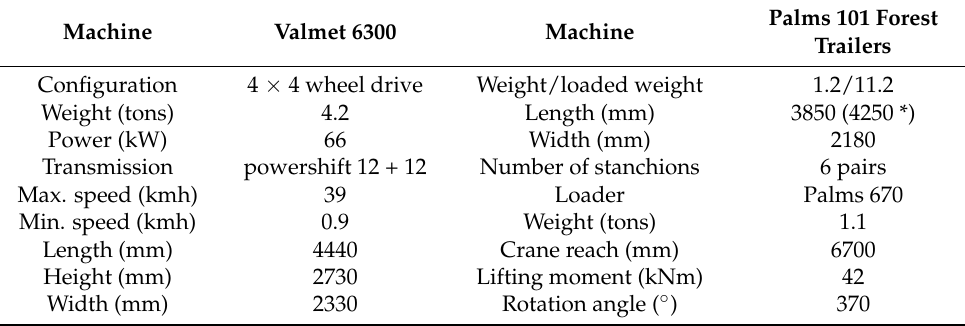
Table 1. Characteristics of the machines in the study [16].